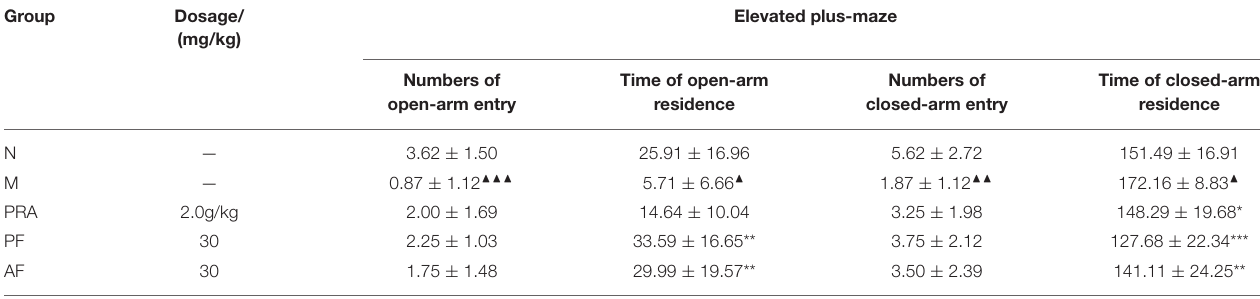
TABLE 2 | Changes in the elevated plus-maze test among groups ( n = 8, ± s). Group Dosage/